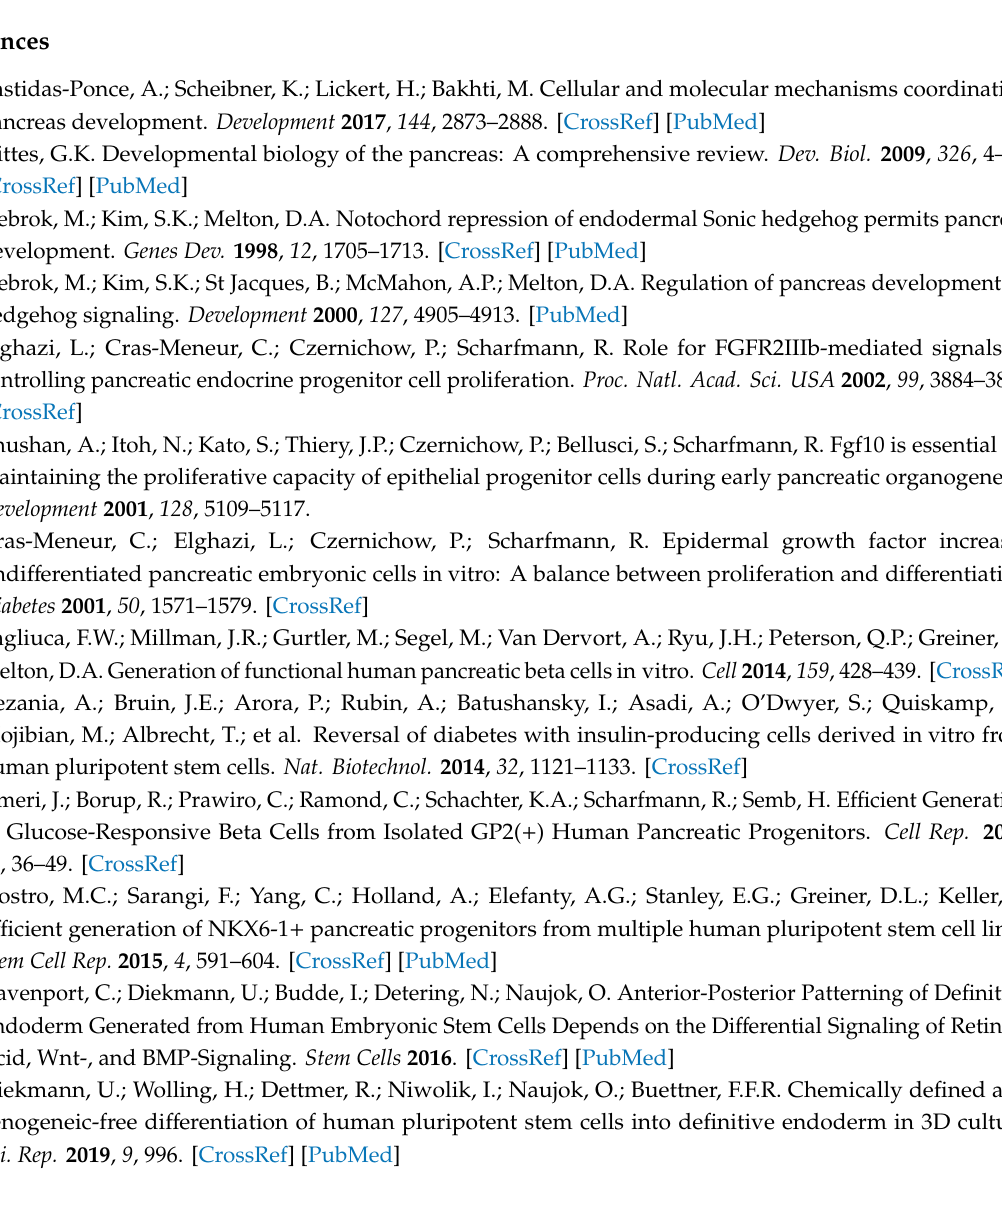
Figure S1: Densiometric quantification, Figure S2: Biological activity of secreted SHH, Figure S3: Workflow of data processing using the Perseus software, Figure S4: Expression of receptors from the TGF-beta-, Wnt-, and FGF-pathway, Table S1: Primer pairs for gene expression analysis. Table S2: Proteins exclusively detected at d0 and d4. Table S3: GO-Term